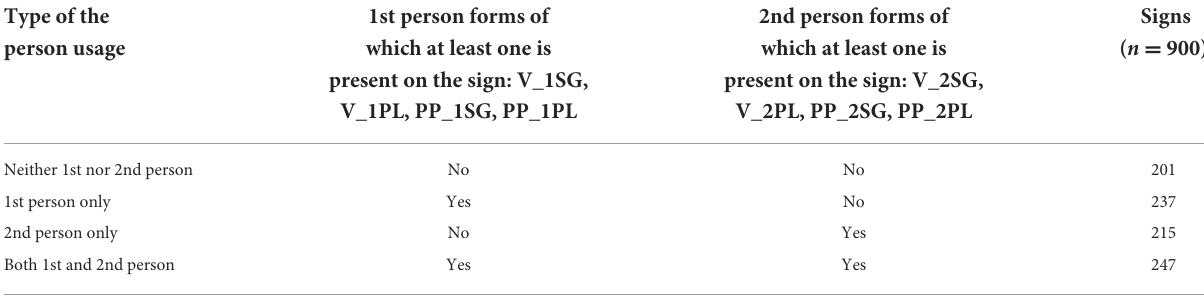
TABLE 2 Types of the person usage on the Estonian COVID-19 signs (V, verb; PP, personal pronoun; SG, singular; PL, plural; 1,2, person). Type of the